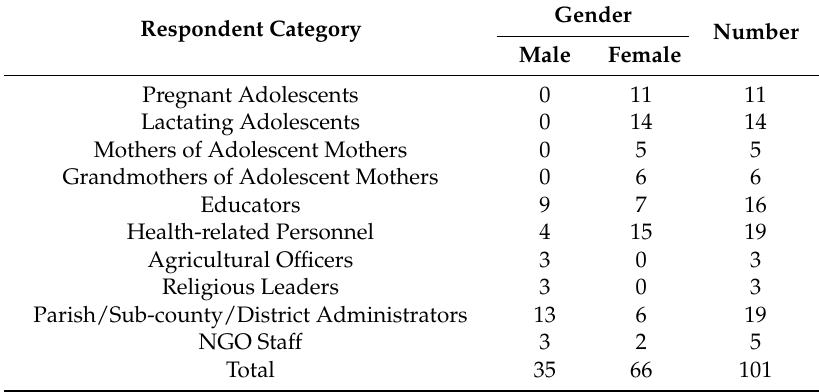
Table 1. Demographics of Study Respondents ( n =